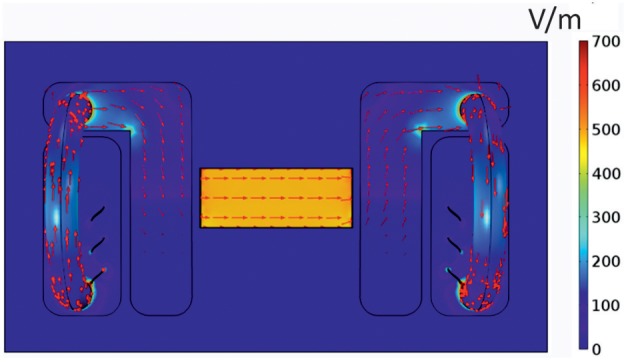
Current distribution in the electrotaxis chamber. Mathematical model of the distribution of the electric field amplitude |E| in V/m (depicted in colored scale) and the current density |J| in A/m2 (red arrows) inside the electrotaxis chamber. The applied voltage between the electrodes was assumed to be 129 V.